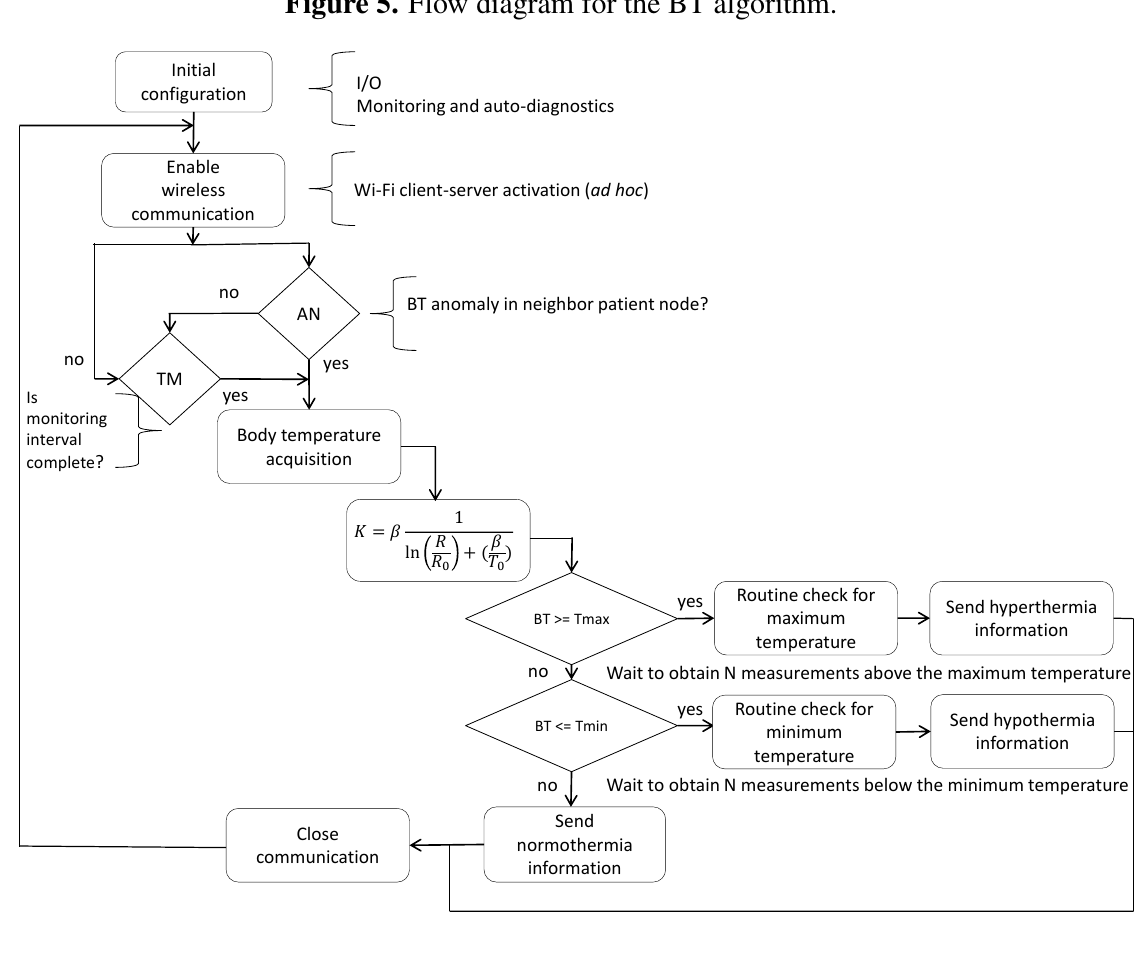
Figure 5. Flow diagram for the BT